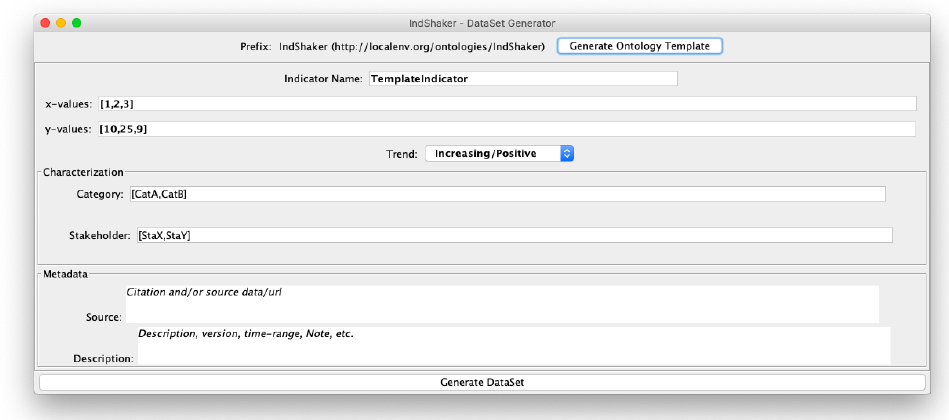
Figure 5. GUI—dataset